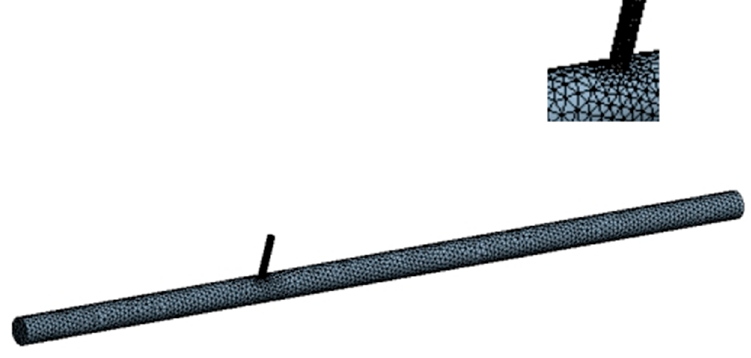
Figure 1. The water and fertilizer mixing pipe model.